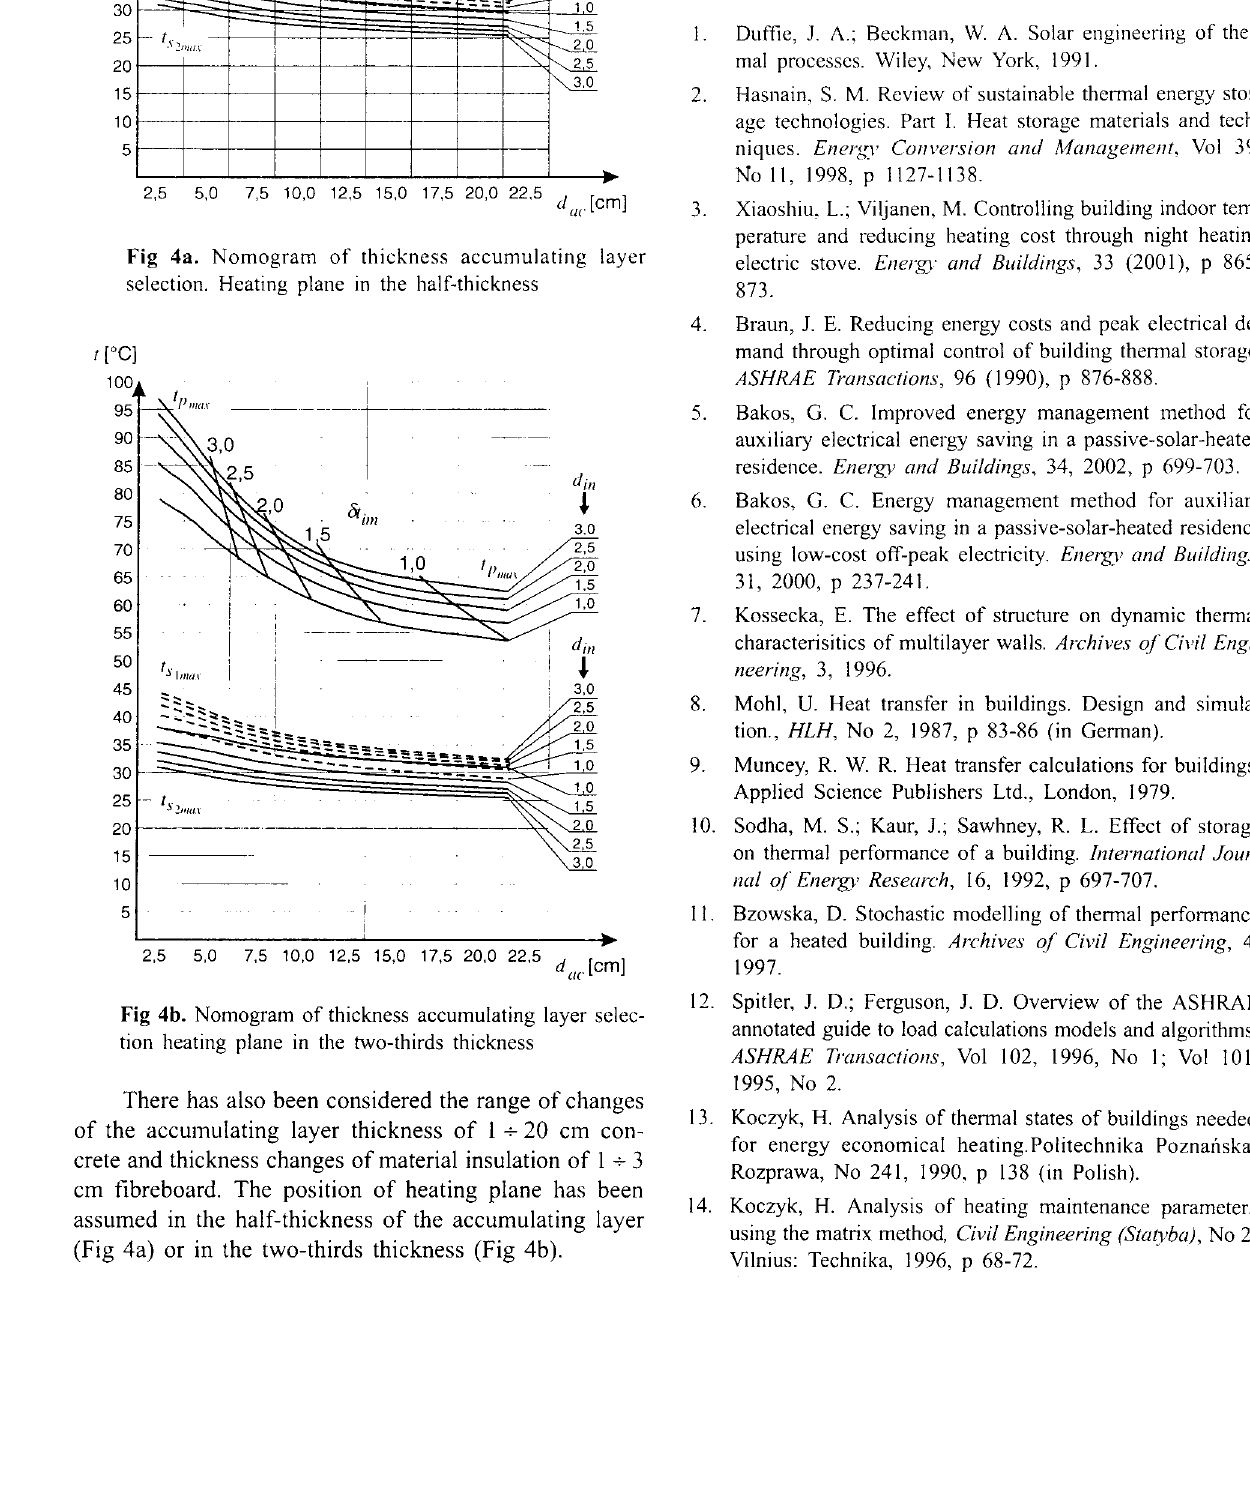
Fig 4a. Nomogram of thickness accumulating layer selection. Heating plane in the half-thickness